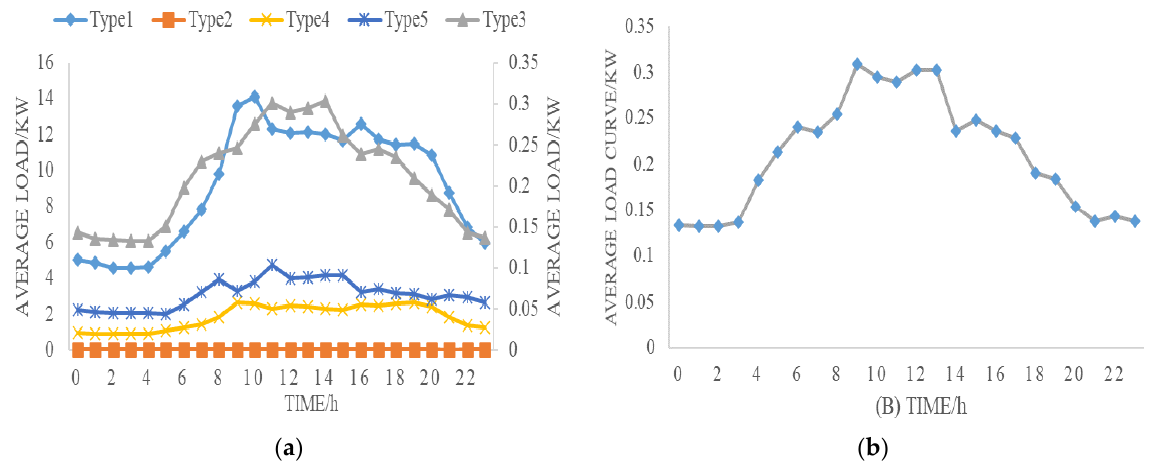
Figure 7. The load curve in August ( a ) clustered 5 types of loads; ( b ) the type 3 load.